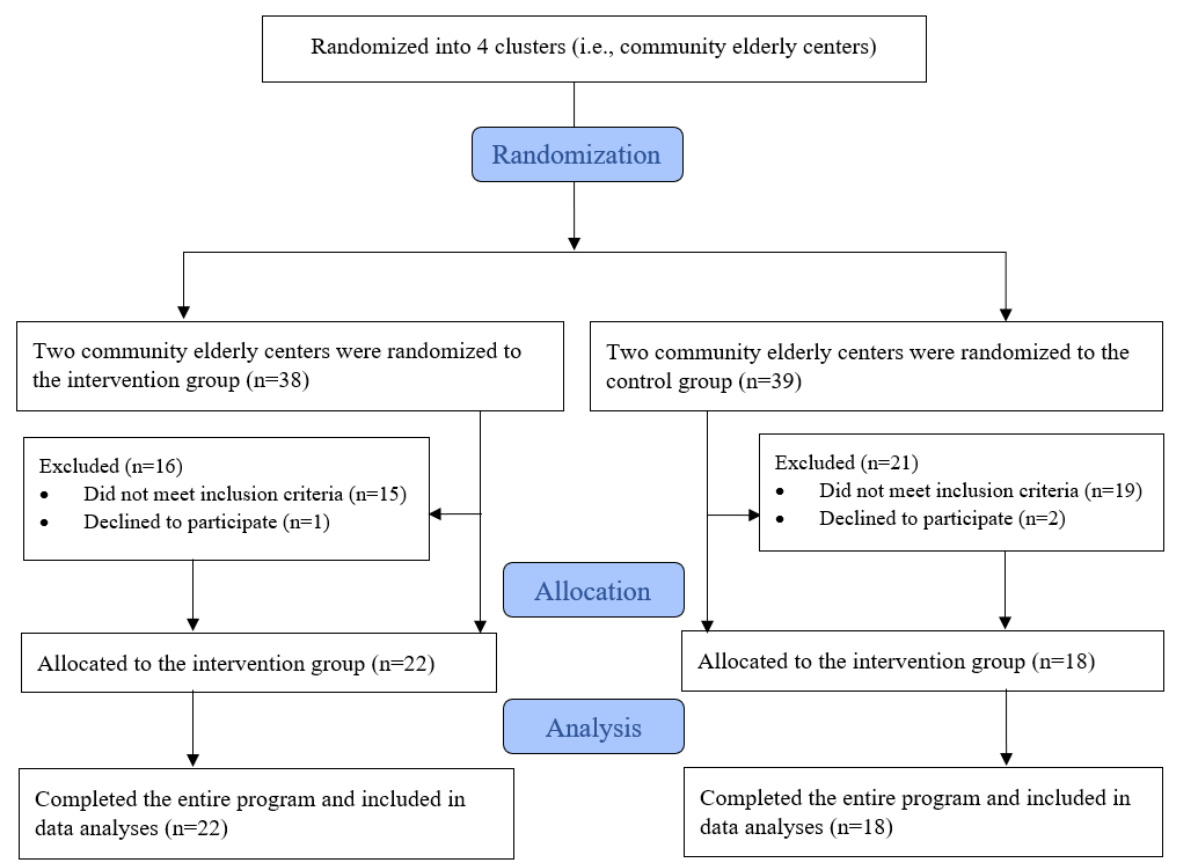
Figure 2. CONSORT diagram through the phases of the study.